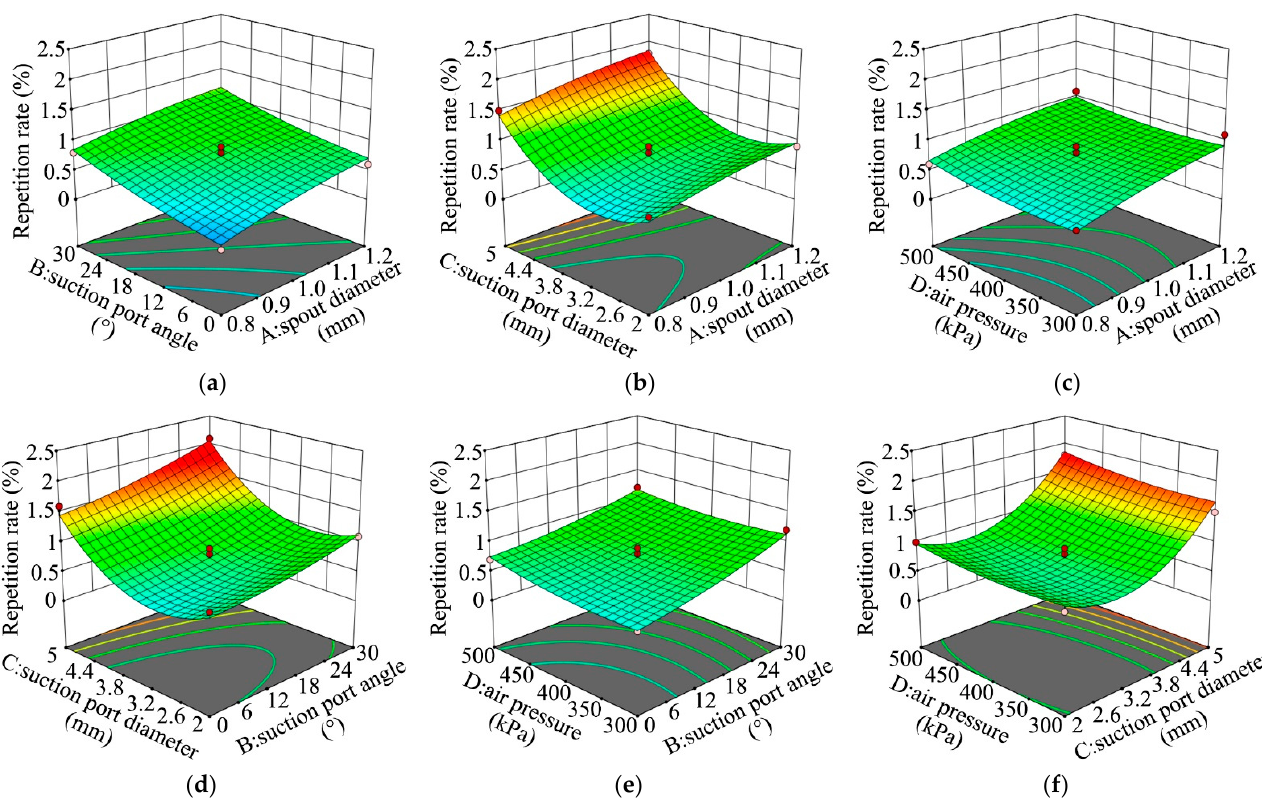
Figure 23. Response surfaces of test factors influence on repetition rate of seed sucking. ( a ) Y 2 ( X 1 , X 2 , 0, 0); ( b ) Y 2 ( X 1 , 0, X 3 , 0); ( c ) Y 2 ( X 1 , 0, 0, X 4 ); ( d ) Y 2 (0, X 2 , X 3 , 0); ( e ) Y 2 (0, X 2 , 0, X 4 ); ( f ) Y 2 (0, 0, X 3 , X 4 ).